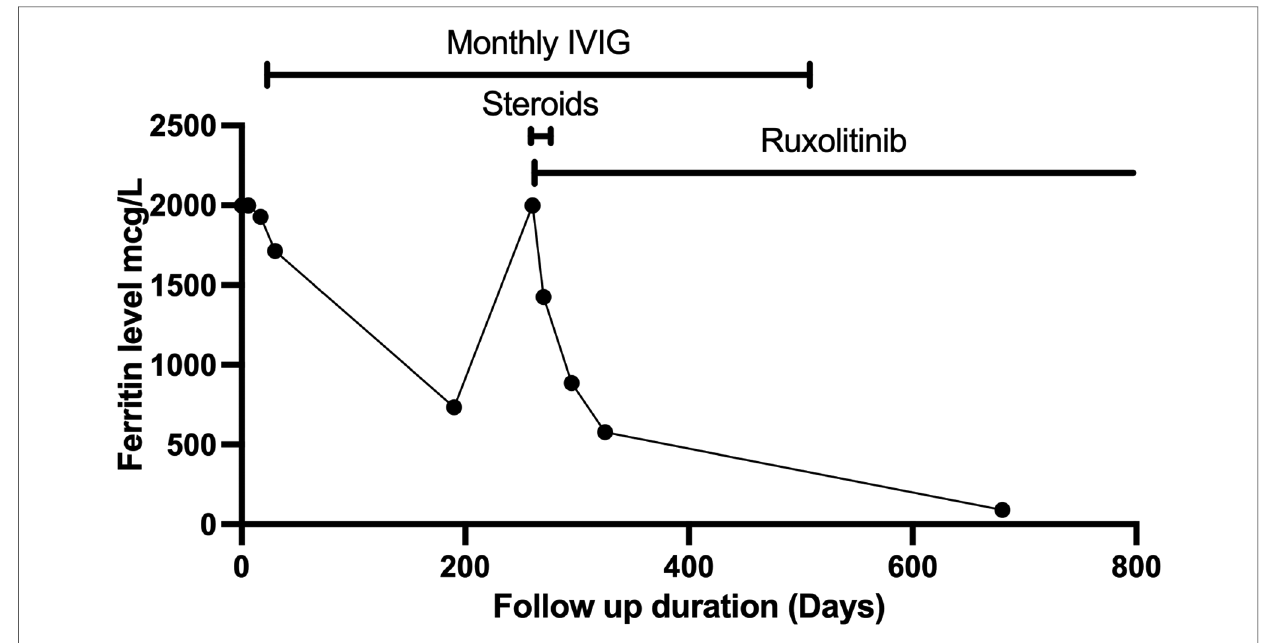
FIGURE 2 The trend in ferritin levels in response to different treatments that were